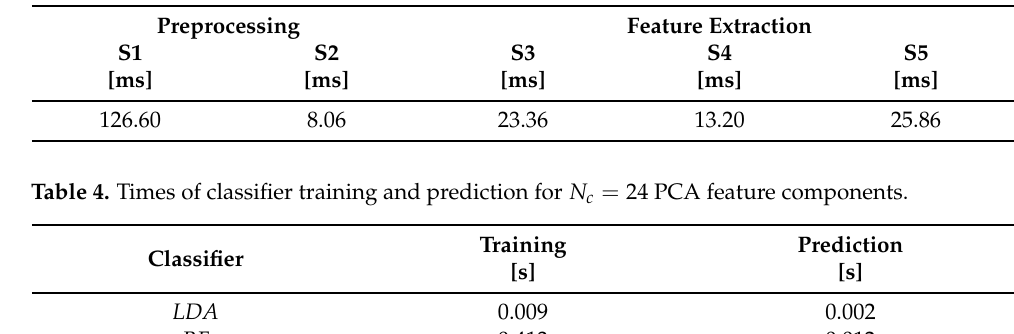
Table 3. Execution times of image preprocessing and textural feature computing for a single image, Haralick, SFTA, and LBP feature extraction.